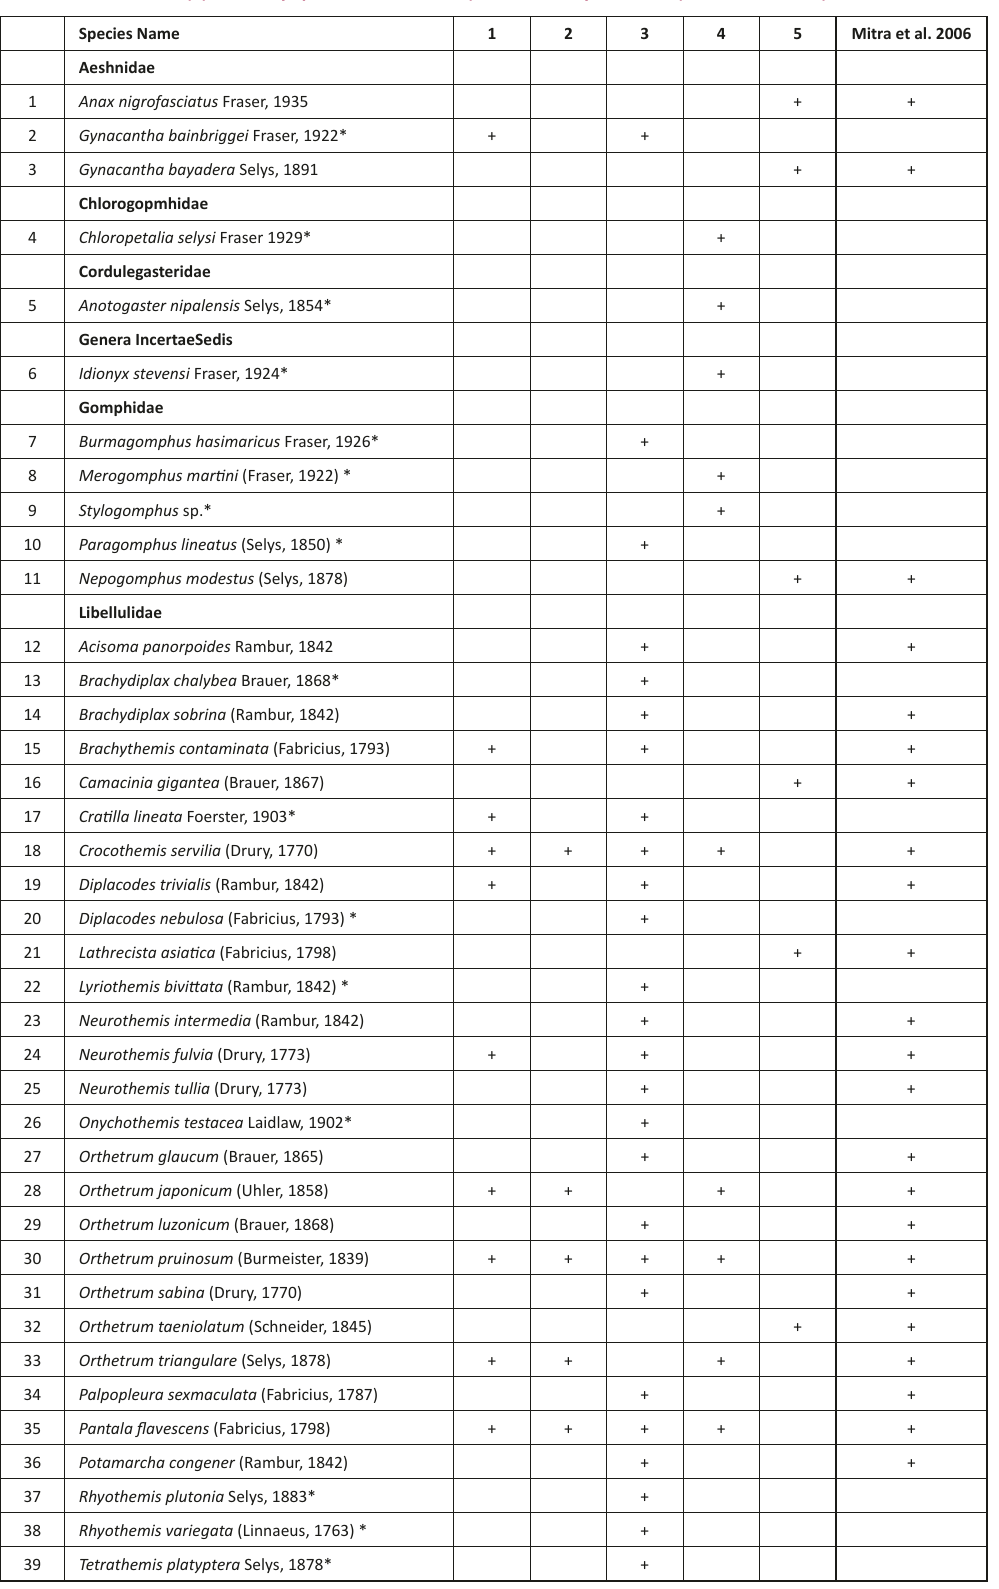
Table 3. Checklist of Odonata of Nagaland. Localities: 1 - Doyang; 2 - Dzulekie; 3 - Intanki; 4 - Khonoma. Column 5 indicates species recorded by Mitra et al. (2006) but not recorded by us. The last column lists species recorded by Mitra et al. (2006). Species new to Nagaland are marked with asterisks (*). The only species new to India ( Calicnemia erythromelas ) is in bold